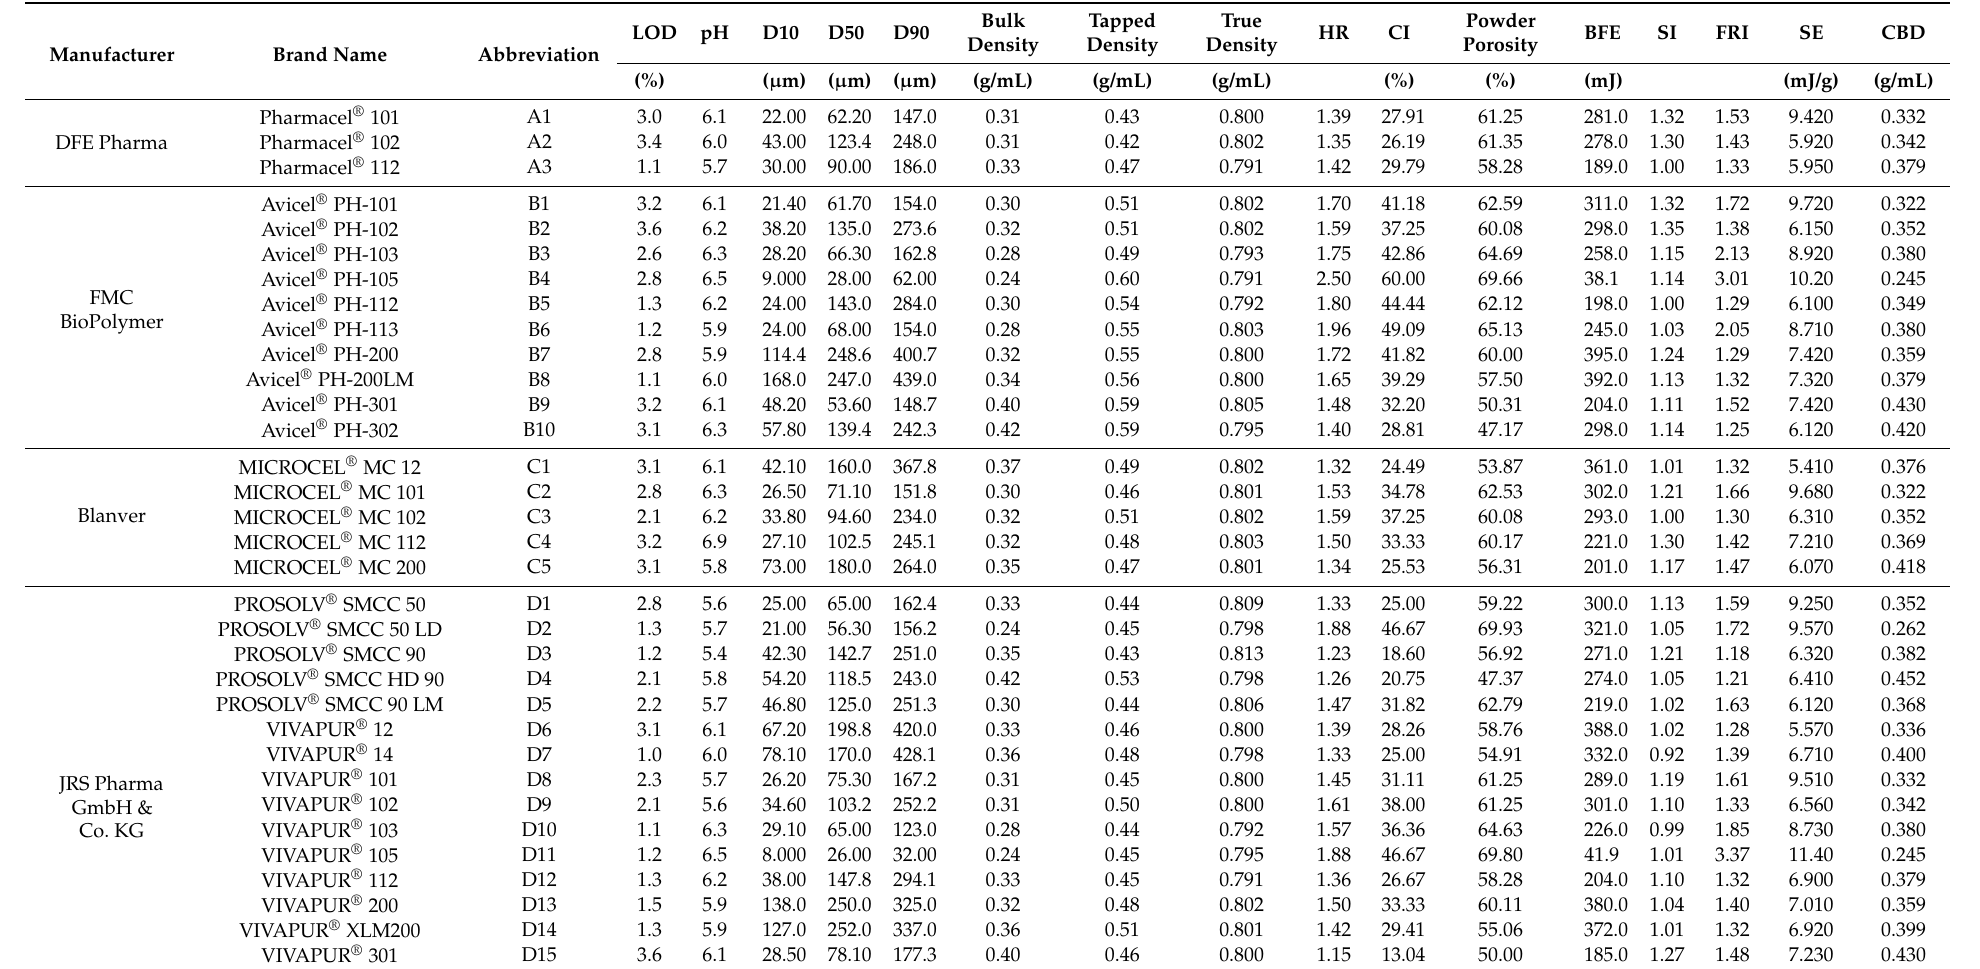
Table 2. Physicochemical properties of 36 different MCCs. (LOD, loss on drying; HR, Hausner ratio; CI, compressibility index; BFE, basic flowability energy; SI, stability index; FRI, flow rate index; SE, specific energy; CBD, conditioned bulk